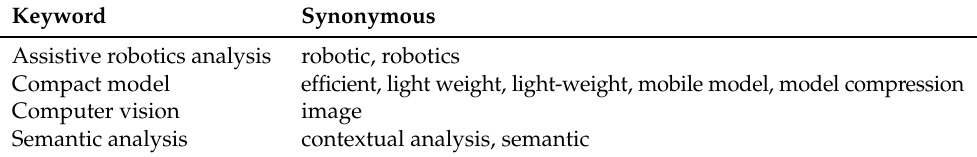
Figure 1. Knowledge fields relating to the research objective and formulated research questions. Table 3. Keywords and synonyms used to generate the search